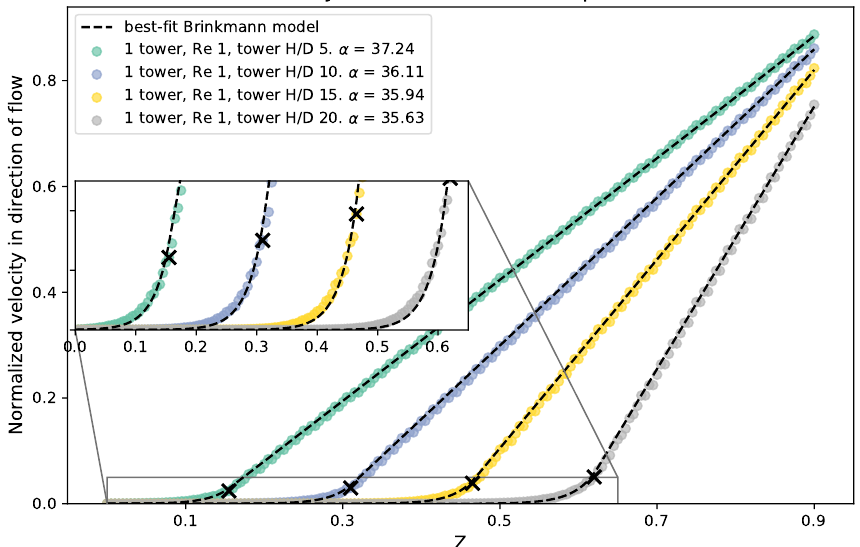
Figure 10. Average velocity in the direction of the flow for various cylinder heights, compared with the best fitting Brinkman model. The top of each cylinder is marked with a black X. The best choice of porosity is given for each cylinder height in the figure